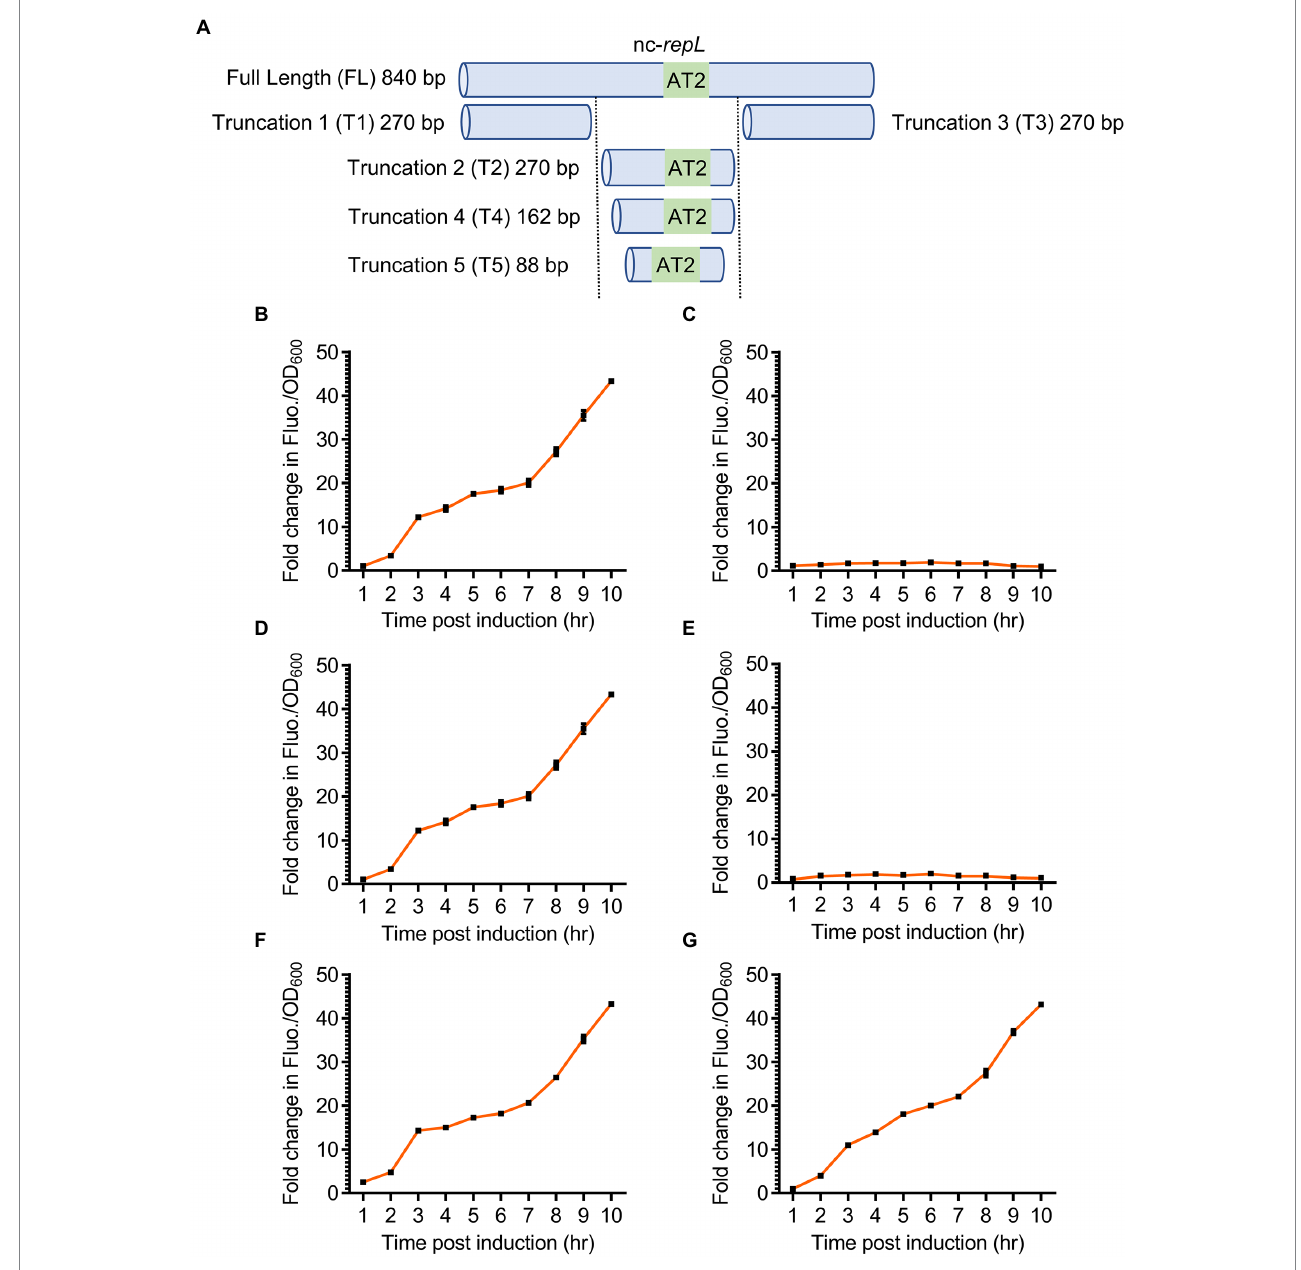
FIGURE 5 Truncated nc- repL sequences could serve as a target site for RepL-mediated signal amplification in trans . (A) Schematic diagram showing a full length and truncated versions of a non-coding repL (nc- repL ) sequence, which were assembled onto a rfp reporter plasmid. Truncation 1 (T1) and Truncation 3 (T3) nc- repL do not contain the AT2 region (43 bp). The sizes of truncated nc- repL sequence were shown. Quantification of the fold change in RFP fluorescence intensity per OD 600 (FIuo./OD 600 ) of TOP10 cells co-transformed with a gfp . repL AT2 plasmid and a rfp plasmid with (B) full length, (C) truncation 1 (T1), (D) truncation 2 (T2), (E) truncation 3 (T3), (F) truncation 4 (T4), or (G) truncation 5 (T5) versions of a nc- repL sequence at 1 to 10 hpi with 1.33 × 10 − 4 M of L-arabinose (orange). Fold changes in the RFP FIuo./OD 600 were calculated based on comparison between arabinose-induced and uninduced state. All RFP fluorescence intensity values were normalized to that of TOP10 cells transformed with empty plasmids without rfp gene and nc- repL sequence. Induction assays were performed with 3 biological replicates and 4 technical replicates. Data were presented as mean ±